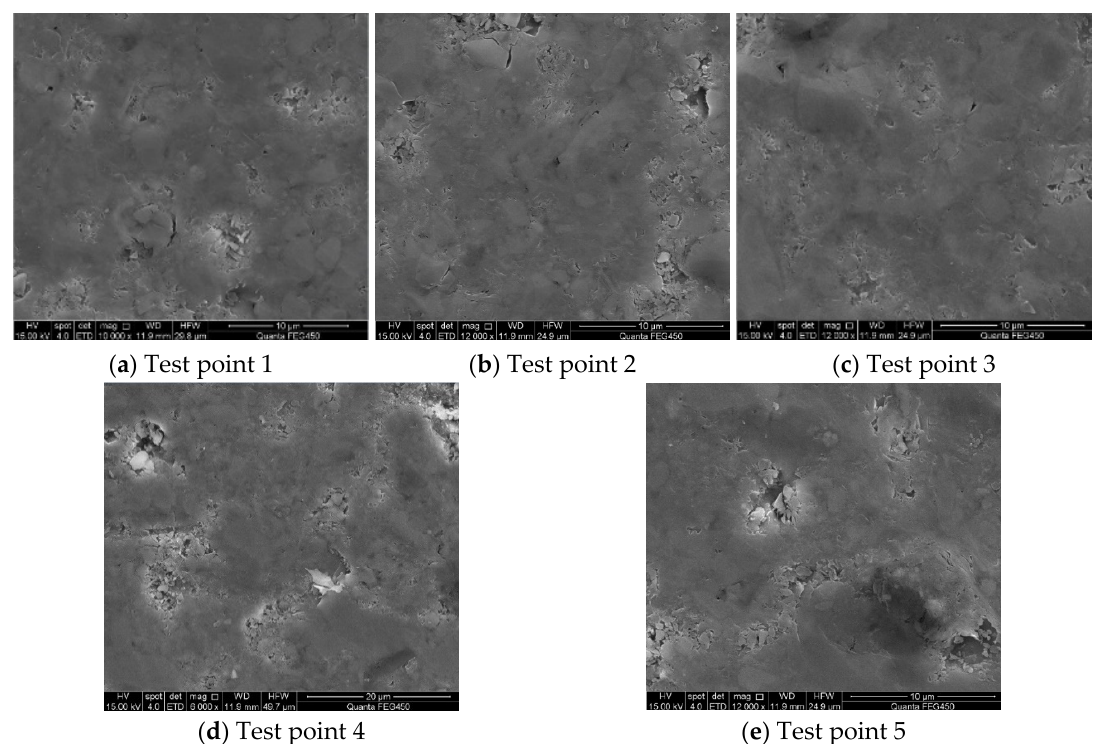
Figure 3. SEM image of CZ-Y47-1 in the direction parallel to the bedding plane.